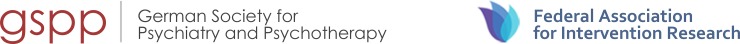
Translated version of the banner for the high source credibility group.